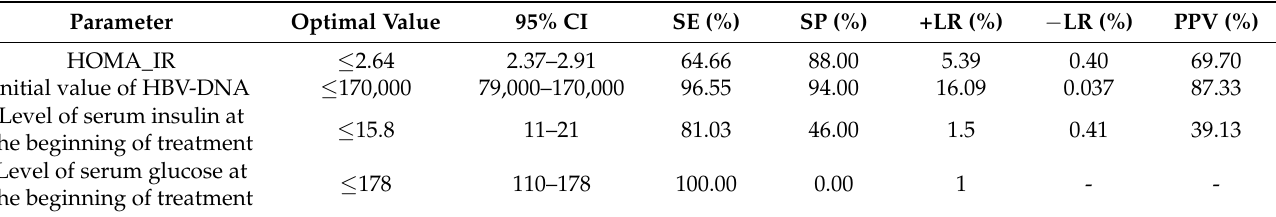
Table 8. Values of the parameters with predictive role for the therapeutic